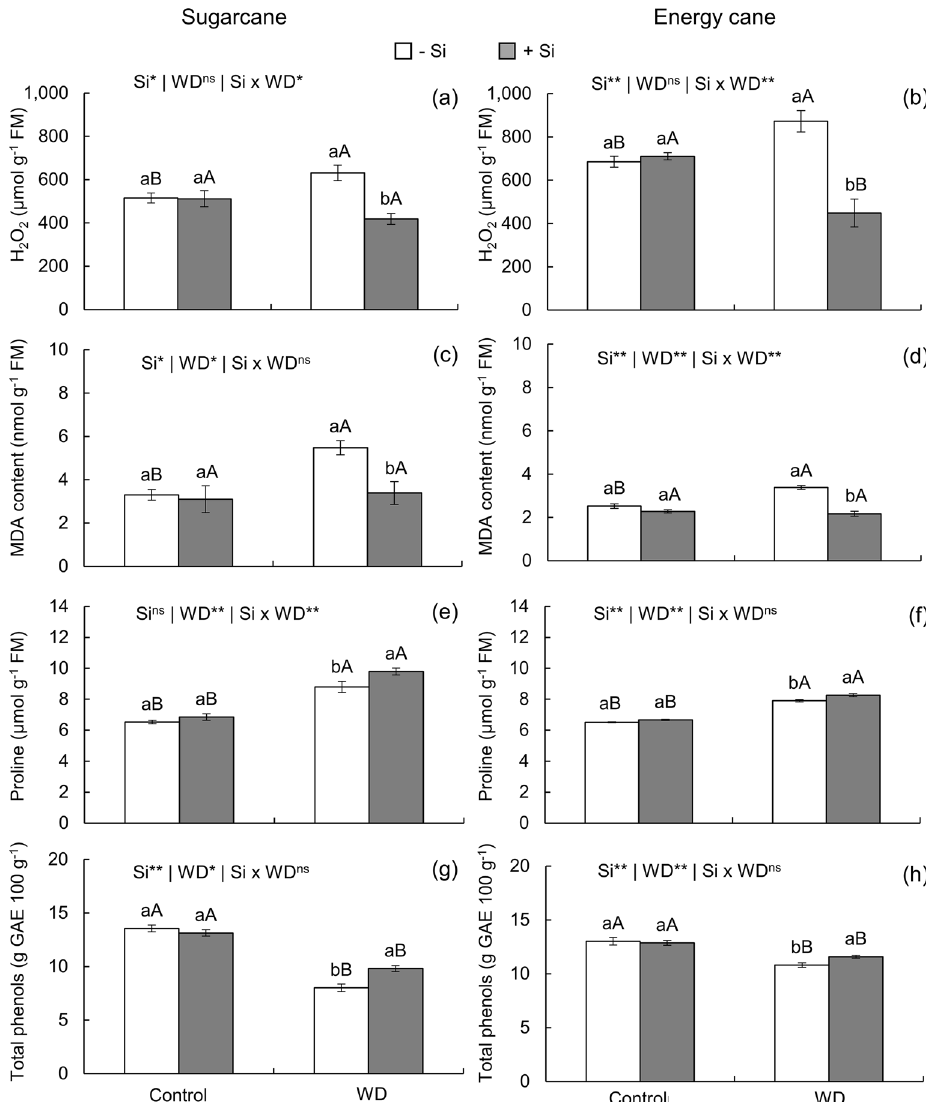
Figure 5. Hydrogen peroxide (H 2 O 2 ), malondialdehyde (MDA), proline, and total phenolic content in sugarcane ( a , c , e , g ) and energy cane ( b , d , f , h ) in the absence of Si (-Si) and with Si applied via fertigation associated with foliar spraying (+ Si) under adequate water regime (control) and severe water deficit (WD) for a period of 7 to 160 days after transplanting. ** and * : significant at 1 and 5% probability, respectively; and ns : not significant by the F-test. Different lowercase letters indicate differences in relation to Si in the same water regime; different capital letters indicate differences in relation to the water regime in the same conditions of Si supply, both by the Tukey test. Bars represent the standard error of the mean; n = 5. FW = fresh weight. GAE = gallic acid